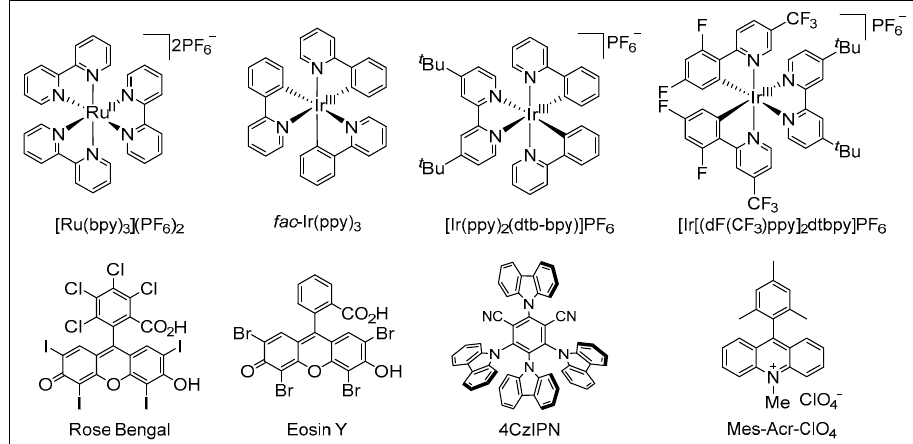
Figure 2. Typical metal-based or organic photoredox catalysts.